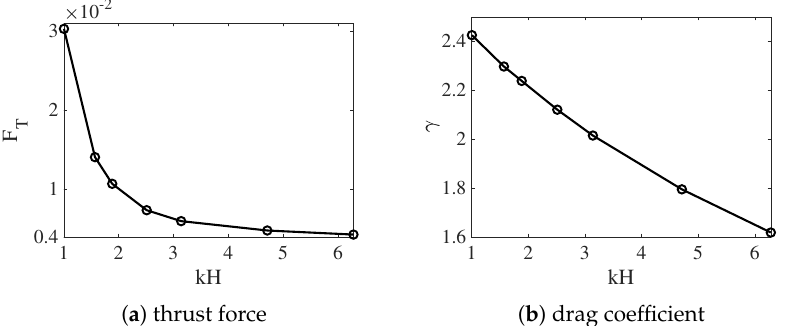
Figure 8. Thrust and drag coefficient vs. the nondimensional interface height kH. β = 0.5. The fluid interfaces are not deformable.